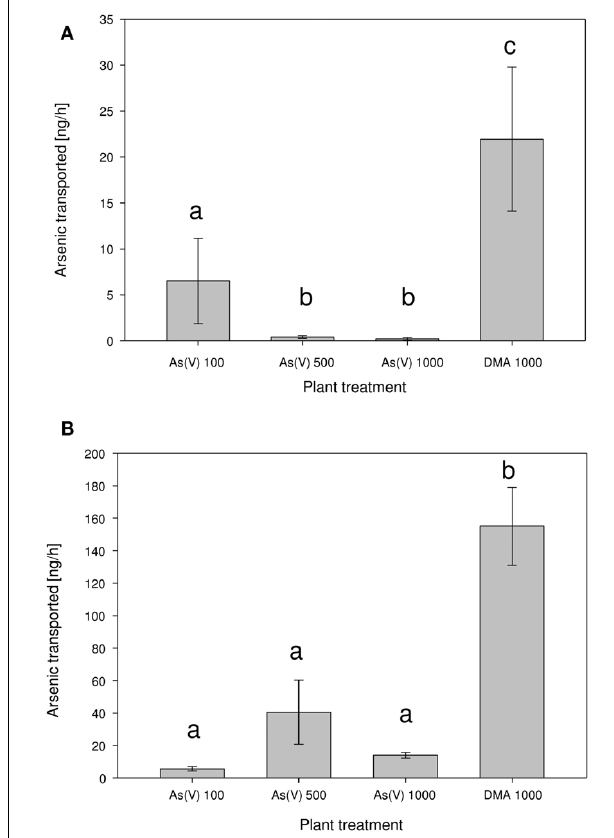
FIGURE 5 |Arsenic amount of sap samples of decapitated cucumbers in experiment B (Figure 5A) and C (Figure 5B) after challenge of plants with no arsenic, DMA at 1000 μ gkg − 1 andAs V at 100, 500, and 1000 μ gkg − 1 for 24h. Sap was collected for 1h ( n = 4). Statistical similarity in one graph is indicated by letter above